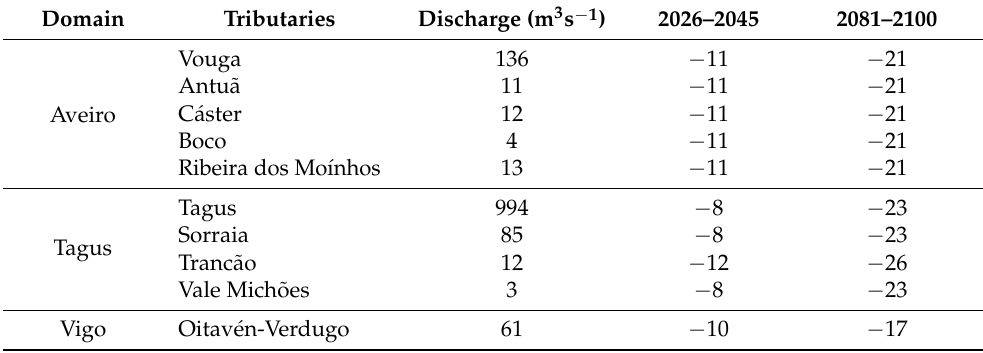
Table 4. Historical average winter river discharge and predictions (%) for the study regions for the middle and end of the